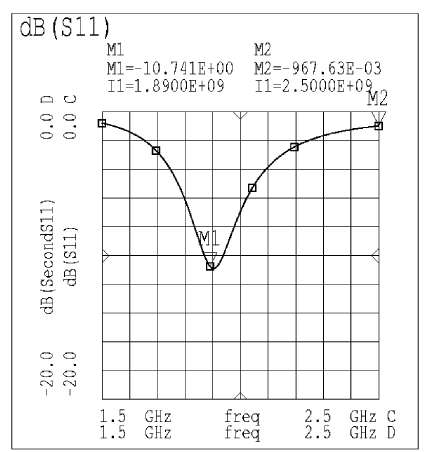
FIGURE 10 Simulation of 1.9GHz F-antenna, input reflection